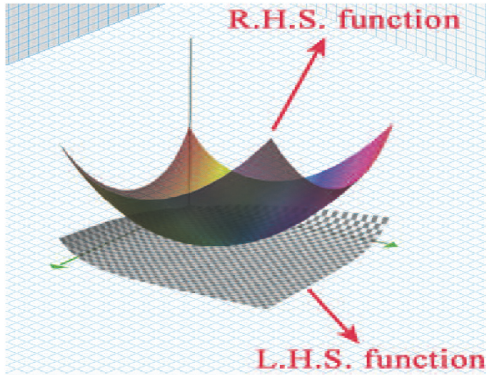
Figure 2: Kannan mapping 󳨐⇒ H G -graph Kannan mapping.